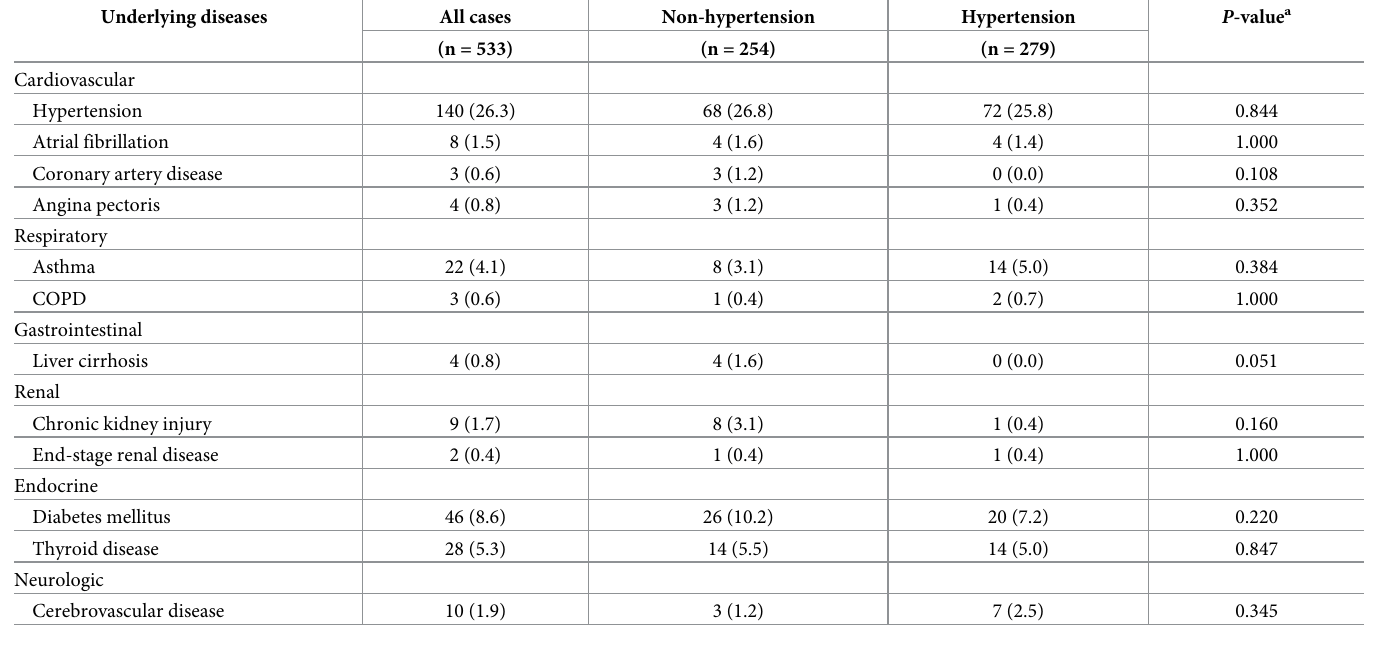
Table 2. Underlying comorbidities of patients based on non-hypertension and hypertension group